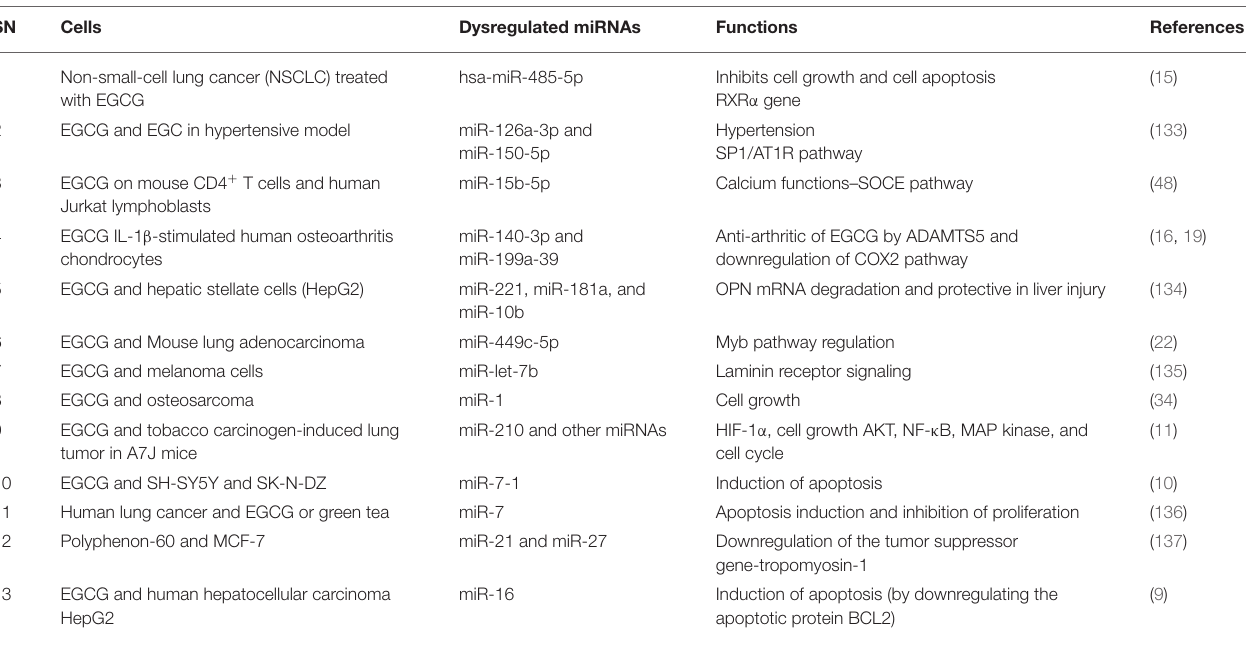
TABLE 2 | Effects of green tea and its different componment on miRNAs expression in cancer and T cells. SN Cells Dysregulated miRNAs